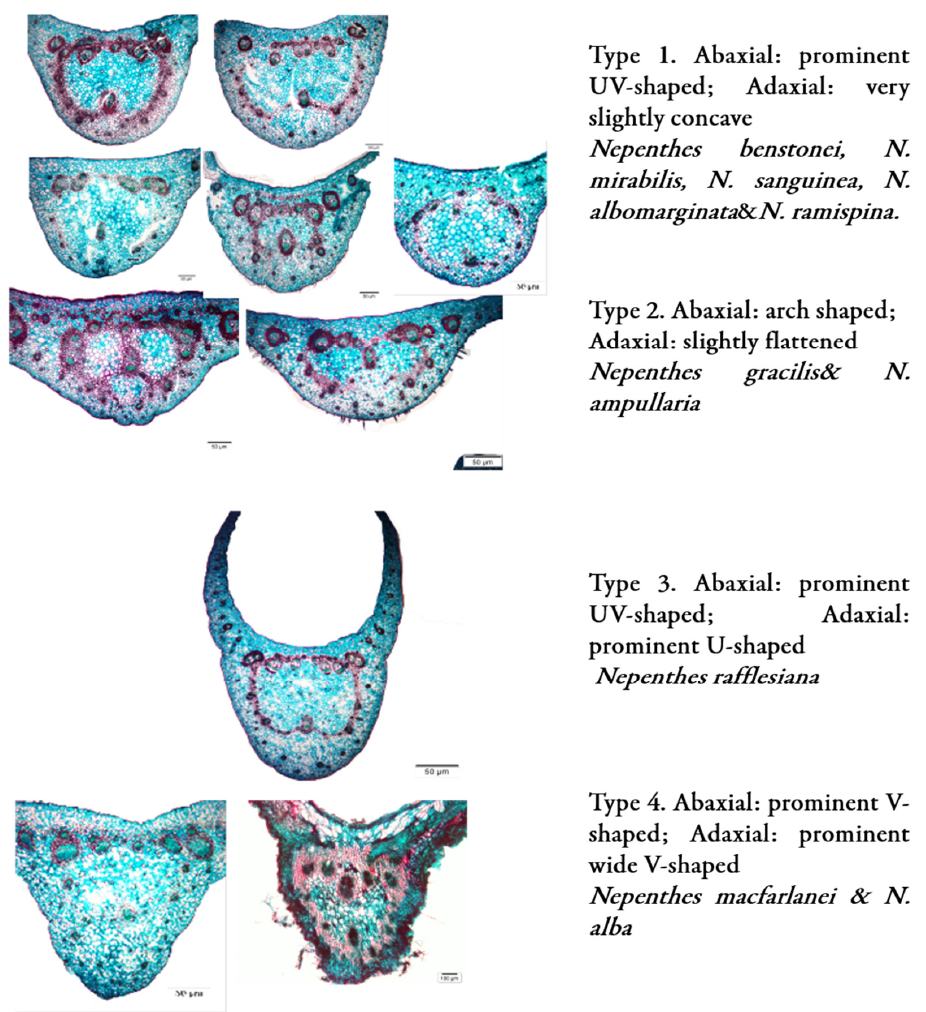
Figure 13. Variation and classification of Nepenthes midrib outer